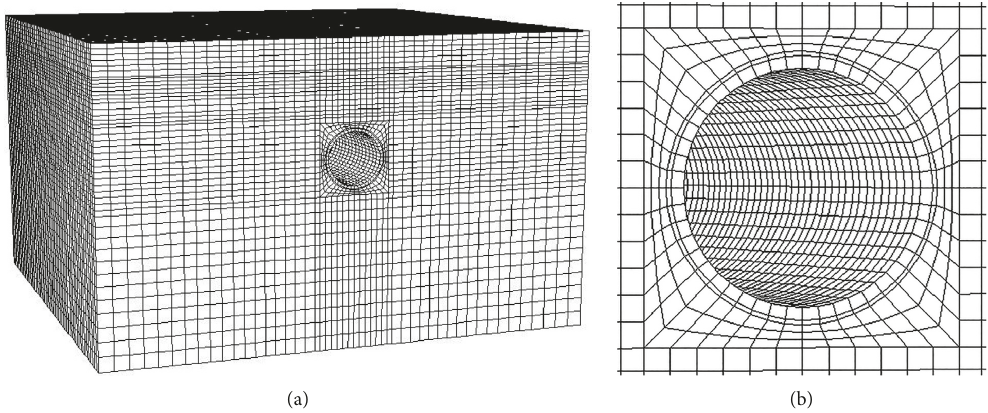
Figure 9: Numerical model introduced into FLAC 3D : (a) perspective view; (b) zoom view.